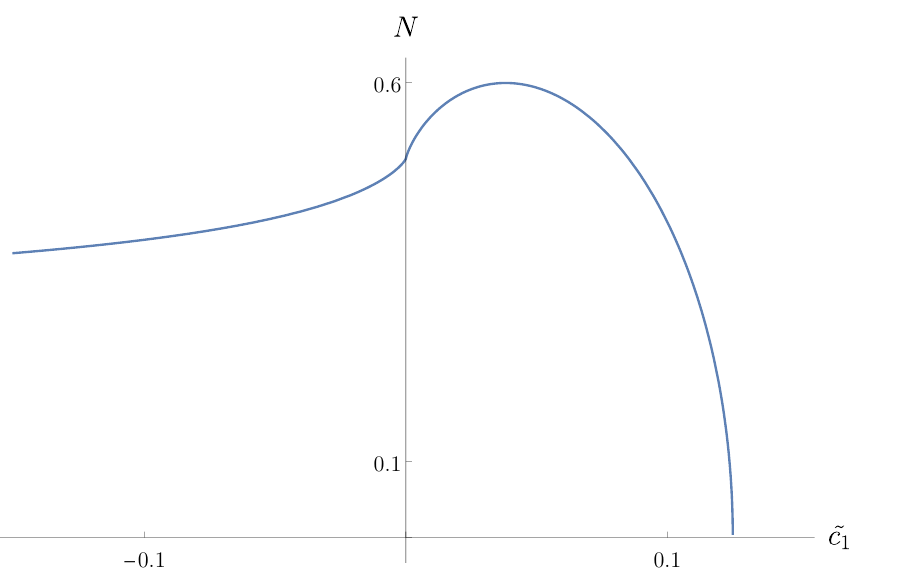
Figure 7 . Number of e-folds N as a function of the parameter ˜ c 1 , for one-flux compactifications. N reaches a maximum of N max = 0 . 59980 , for ˜ c 1 = 0 . 038148